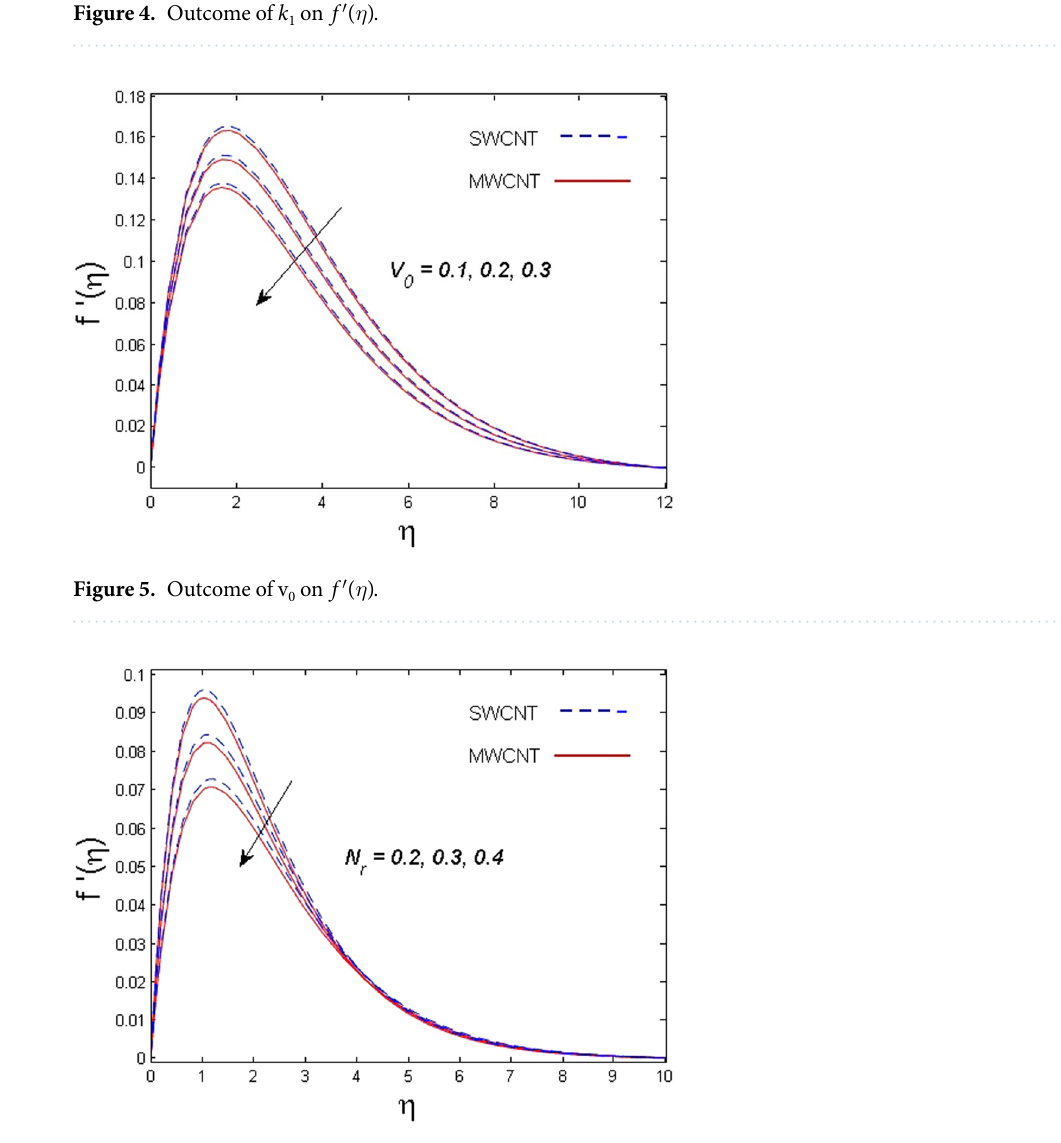
Figure 6. Outcome of N r on η ′ f ( )